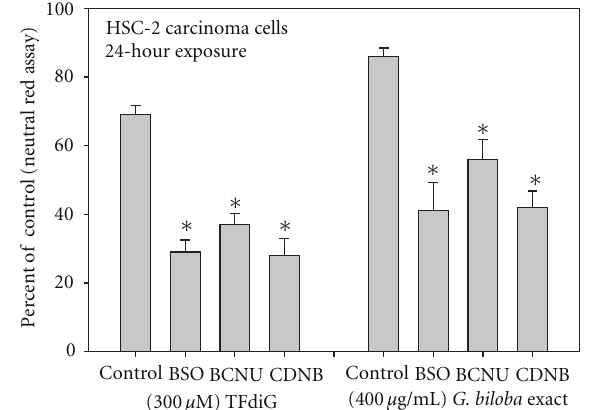
Figure 4: Comparative toxicities of theaflavin-3,3 (cid:2) -digallate (TFdiG) and Ginkgo biloba extract towards human oral HSC-2 carcinoma cells, untreated (control) and treated with glutathione depleters. Cell proliferation was quantified with the neutral red assay, a cell viability assay. Data are presented as the mean percent of control ± S.E.M. Data for the TFdiG study are from Schuck et al. [19] and for G. biloba from Babich et al.